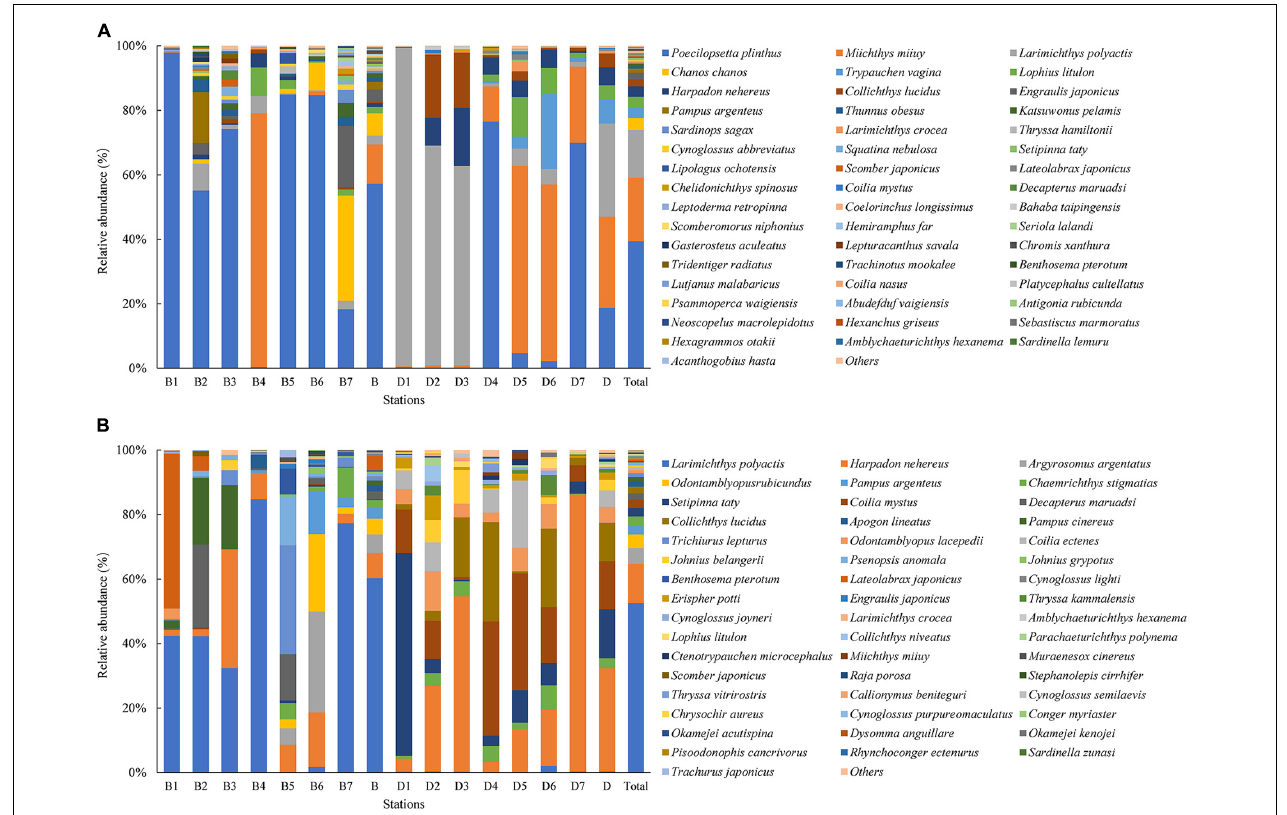
FIGURE 6 | Top 50 relative abundance (%) of fish species in different seasons detected in every sampling site according to (A) eDNA metabarcoding and (B) bottom trawling in the Zhoushan Sea (China). B1–7 are different stations in summer, B stands for the total of all sites in summer. D1–7 are different stations in winter, D stands for the total of all sites in winter.